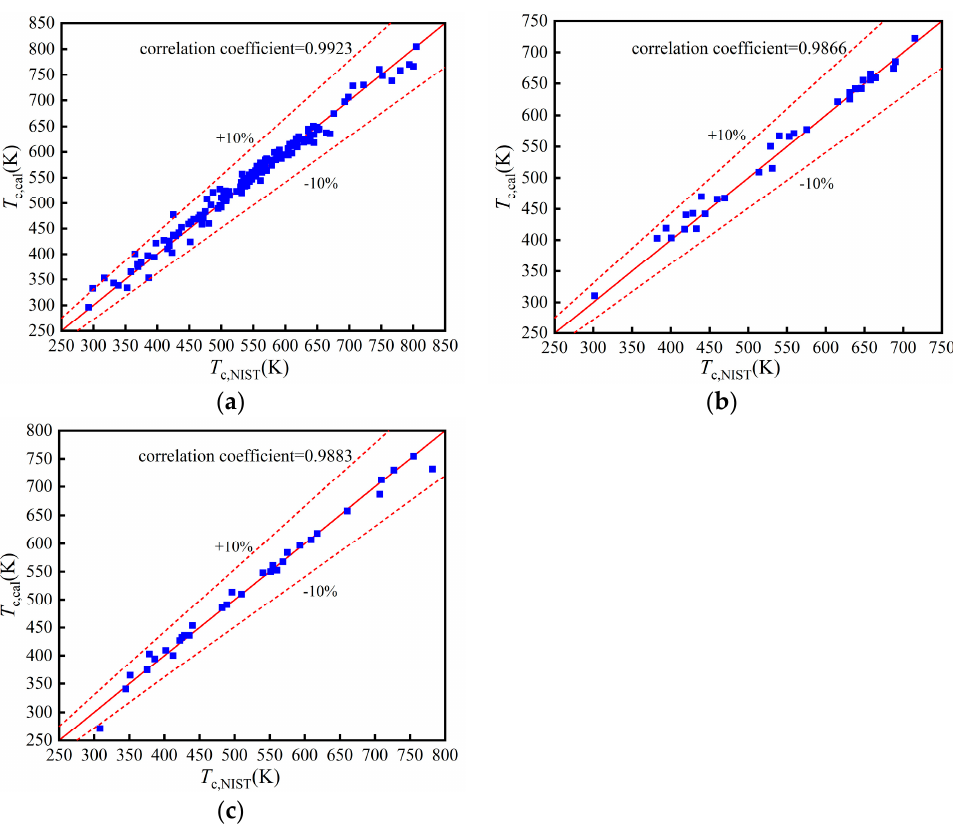
Figure 3. Comparison of T c : ( a ) Training set; ( b ) Validation set; ( c ) Test set. Table 2. Comparison of the statistical parameters for four properties.